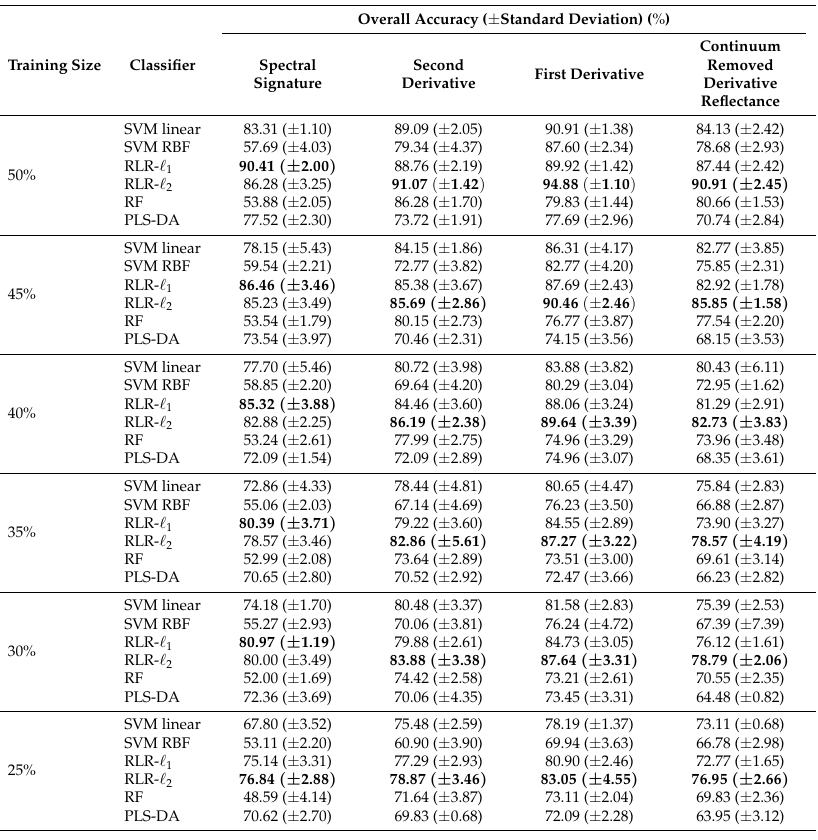
Table 18. Vegetation types identification accuracies (overall accuracy ( ± standard deviation) in %) on [750–1350